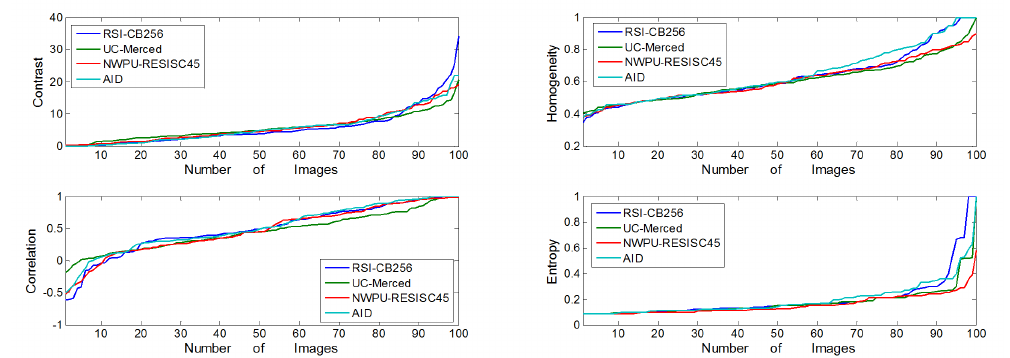
Figure 9. Comparison of image texture features among the four benchmarks using